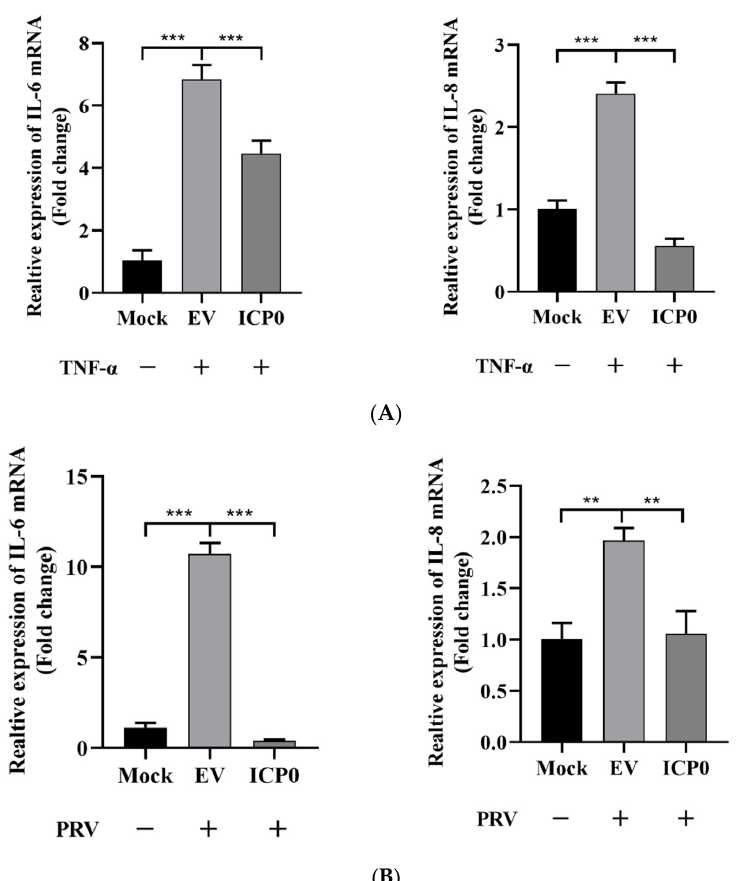
Figure 2. Viral protein ICP0 inhibits IL-6 and IL-8 mRNA transcription. ( A ) PK15 cells were